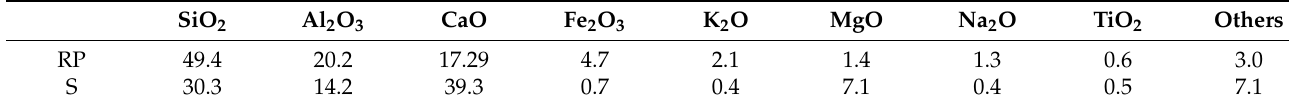
Figure 1. The preparation process of RP.